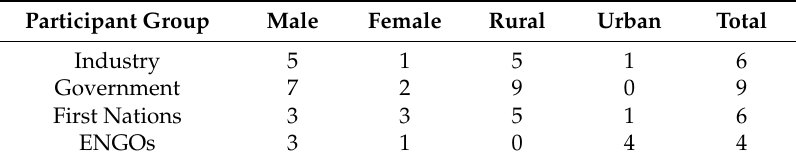
ENGOs, environmental non-government